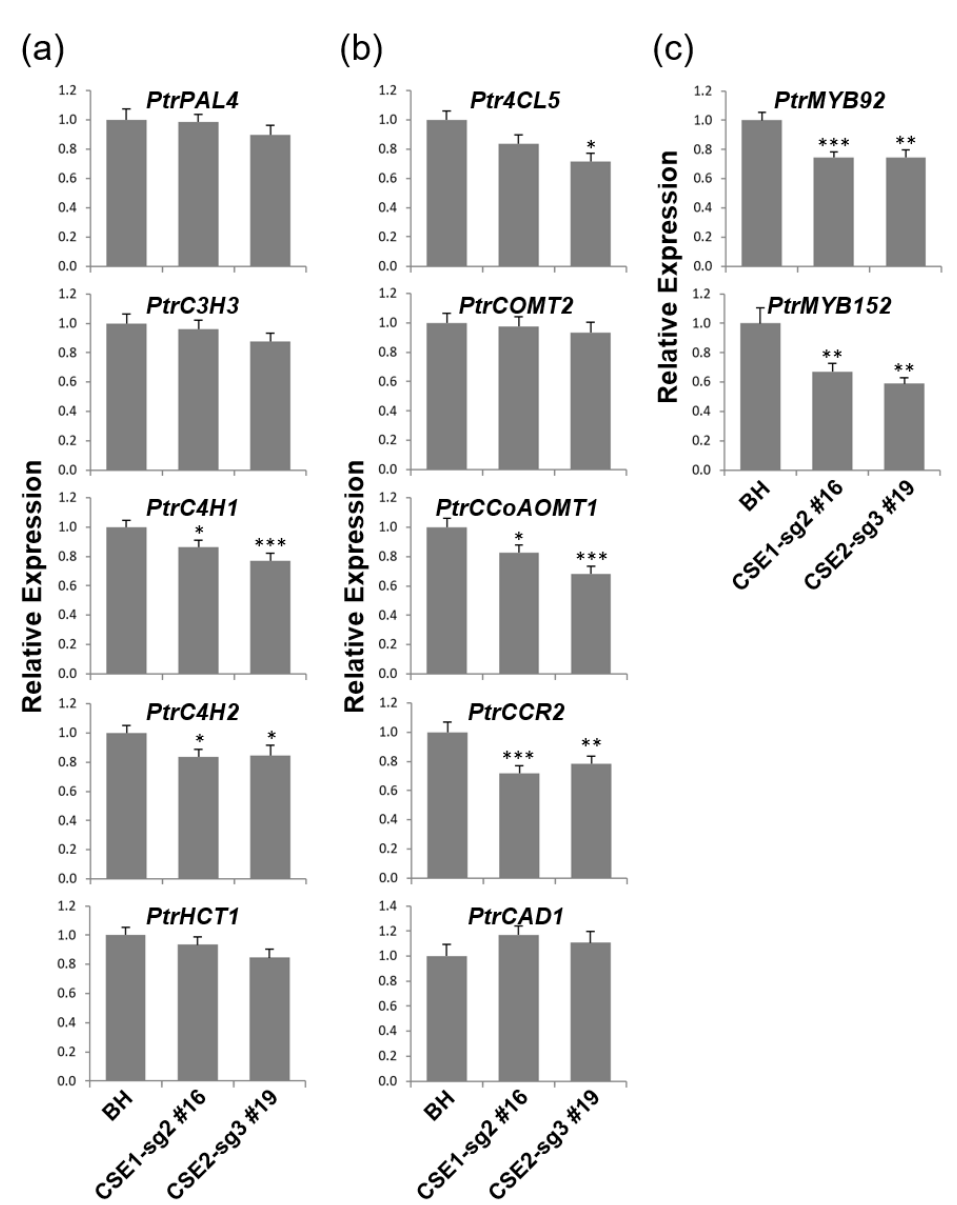
Figure 5. Expression of genes involved in lignin biosynthesis in transgenic CSE-CRISPR hybrid poplars. ( a ) Genes in the early steps of the lignin biosynthesis pathway: PtrPAL4 (Potri.010G224100.1); PtrC3H3 (Potri.006G033300.1); PtrC4H1 (Potri.013G157900.1); PtrC4H2 (Potri.019G130700.1); PtrHCT1 (Potri.003G183900.1). ( b ) Genes in the later steps of the lignin biosynthesis pathway: Ptr4CL5 (Potri.003G188500.1); PtrCOMT2 (Potri.012G006400.1); PtrCCoAOMT1 (Potri.009G099800.1); PtrCCR2 (Potri.003G181400.1); PtrCAD1 (Potri.009G095800.1). ( c ) Transcriptional regulation: PtrMYB92 (Potri.001G118800.1) and PtrMYB152 (Potri.017G130300.1). Relative expression (log 2 scale) were determined by RT-qPCR using the PtrACTIN7 gene as a quantitative control. Total RNA was extracted from the stems of 4-month-old poplars. Asterisks indicate significant differences compared to BH using the unpaired Student’s t -test (* p -value < 0.05, ** p -value < 0.01, *** p -value < 0.001). Error bars indicate the standard errors of three independent